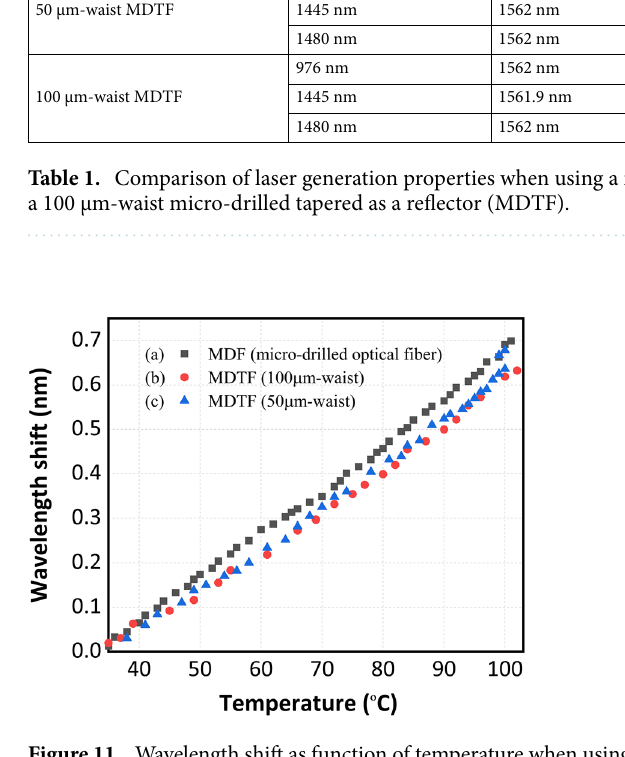
Figure 11. Wavelength shift as function of temperature when using ( a ) the MDF, ( b ) the MDTFs with 100 μm-waist or ( c ) the 50 μm-waist as temperature